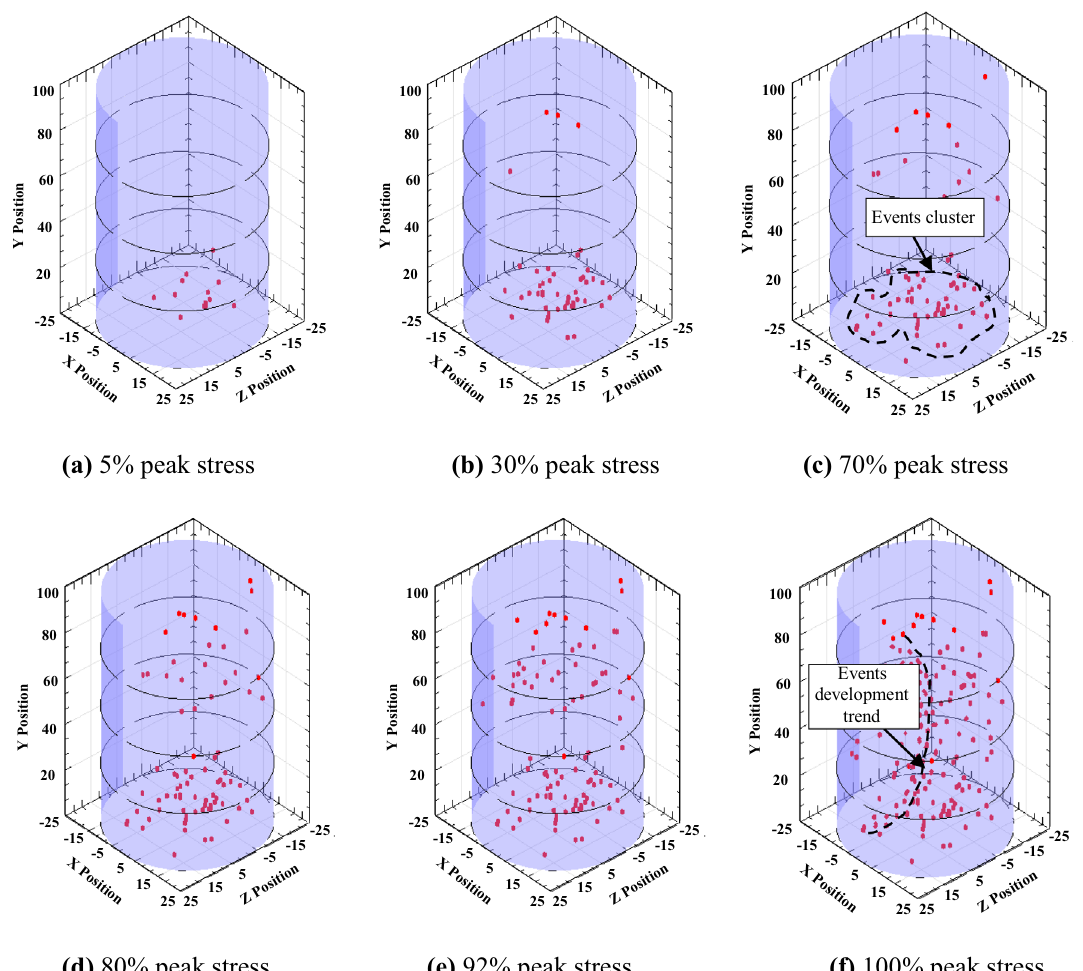
Fig. 11 AE events localization results for specimen